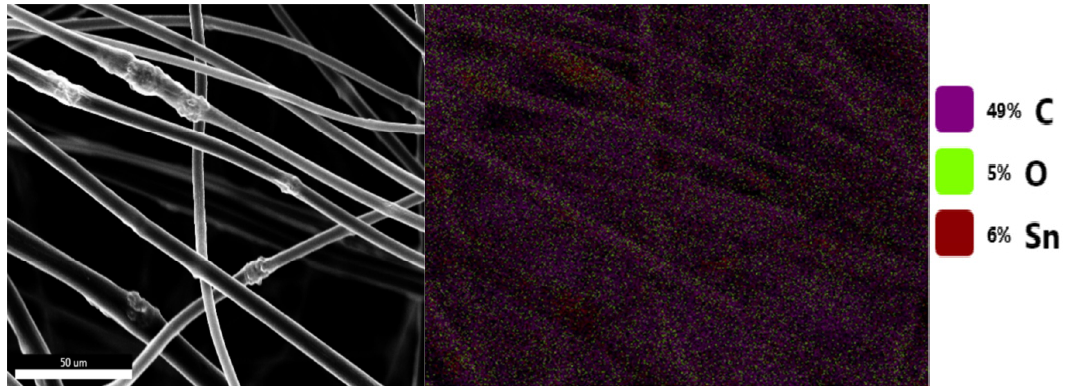
Figure 2. SEM image of SnO 2 /C composite fibers (left) and corresponding EDS mapping of the SnO 2 /C composite fibers (right).